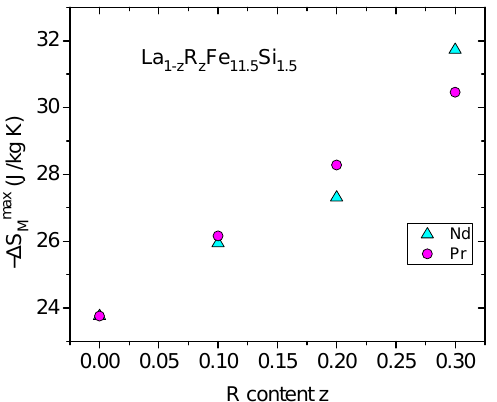
Figure 8. ∆ S max vs. R content z , for La 1 − z R z Fe 11.5 Si 1.5 (R = Nd, Pr) [61,62]. M